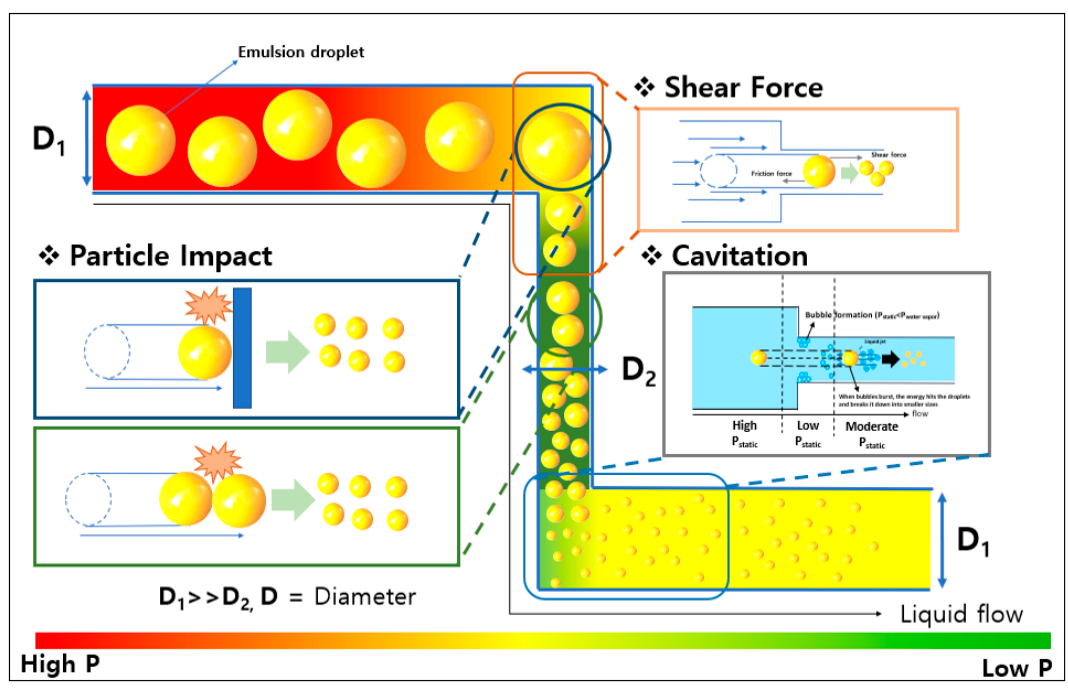
Figure 5. Phenomena in homogenization chamber.